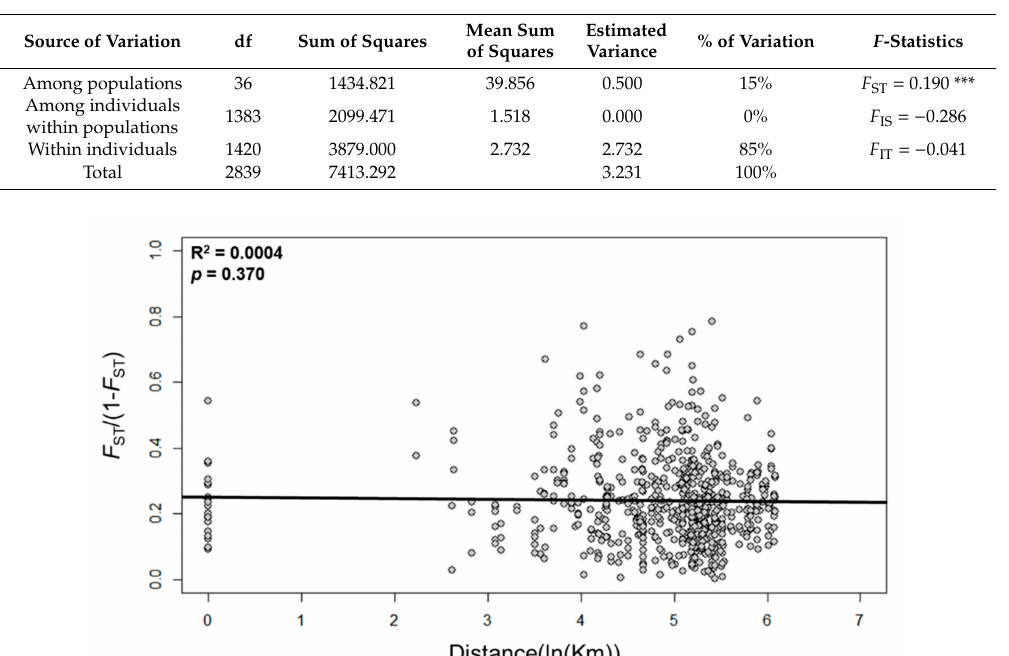
Table 3. Analysis of molecular variance (AMOVA) analysis on eight microsatellites in di ff erent